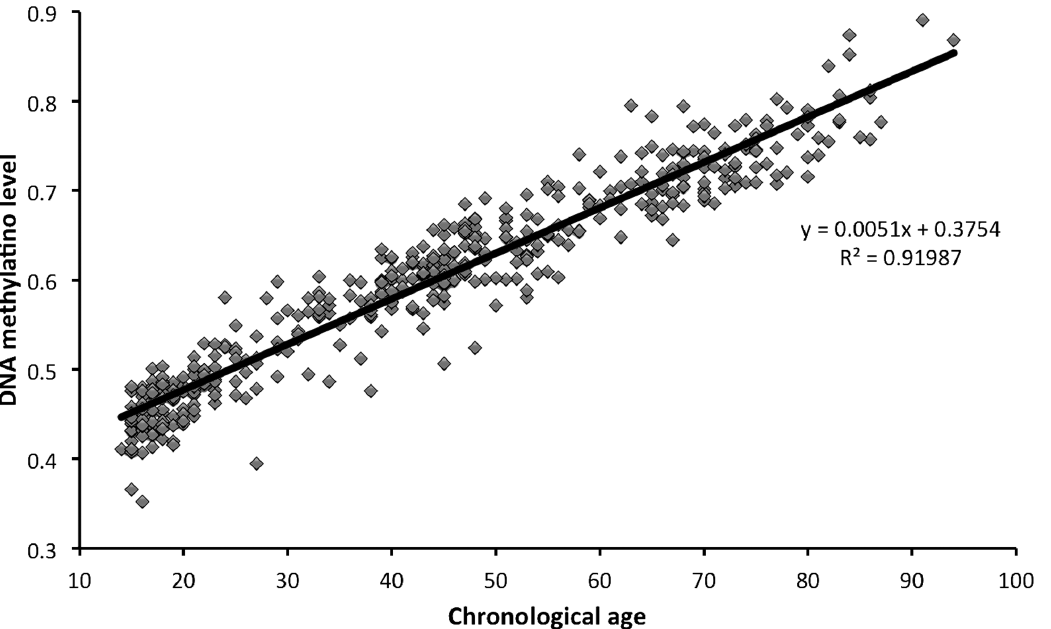
Figure 2. Increase in DNA methylation level with age of one CpG site (cg16867657) in the promoter of the ELOVL2 gene and corresponding regression line.